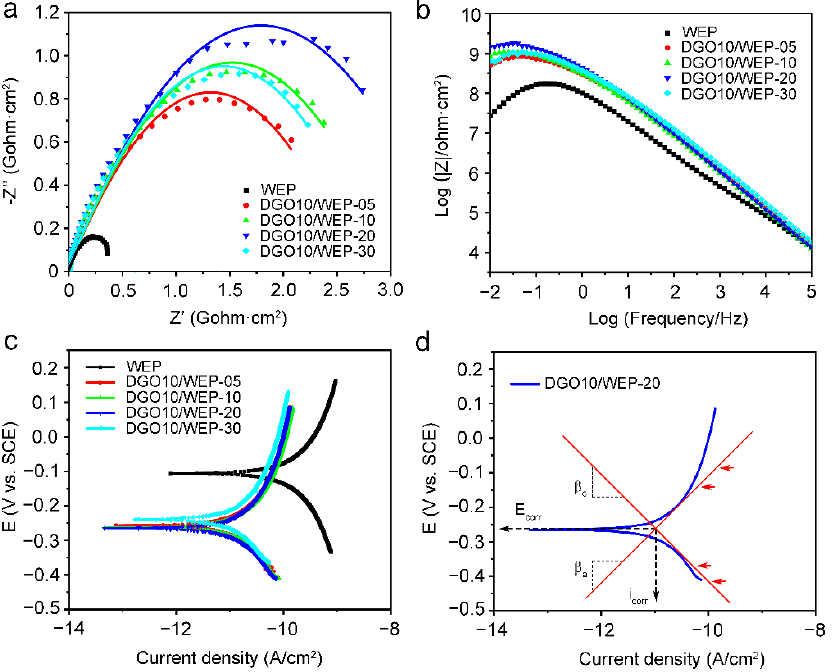
Figure 4. Nyquist diagrams ( a ), Bode diagrams ( b ), and potentiodynamic polarization curves ( c ) of waterborne epoxy resin coatings after immersion in 3.5 wt.% NaCl solution for 48 h. Tafel extrapolation on the polarization plot of the DGO10/WEP-20 sample for the determination of the corrosion current and Tafel slopes ( d ).